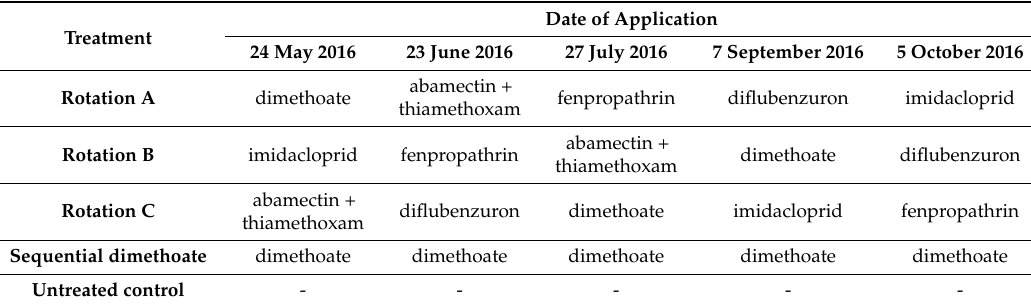
Table 2. Rotation schedule treatments and dates of